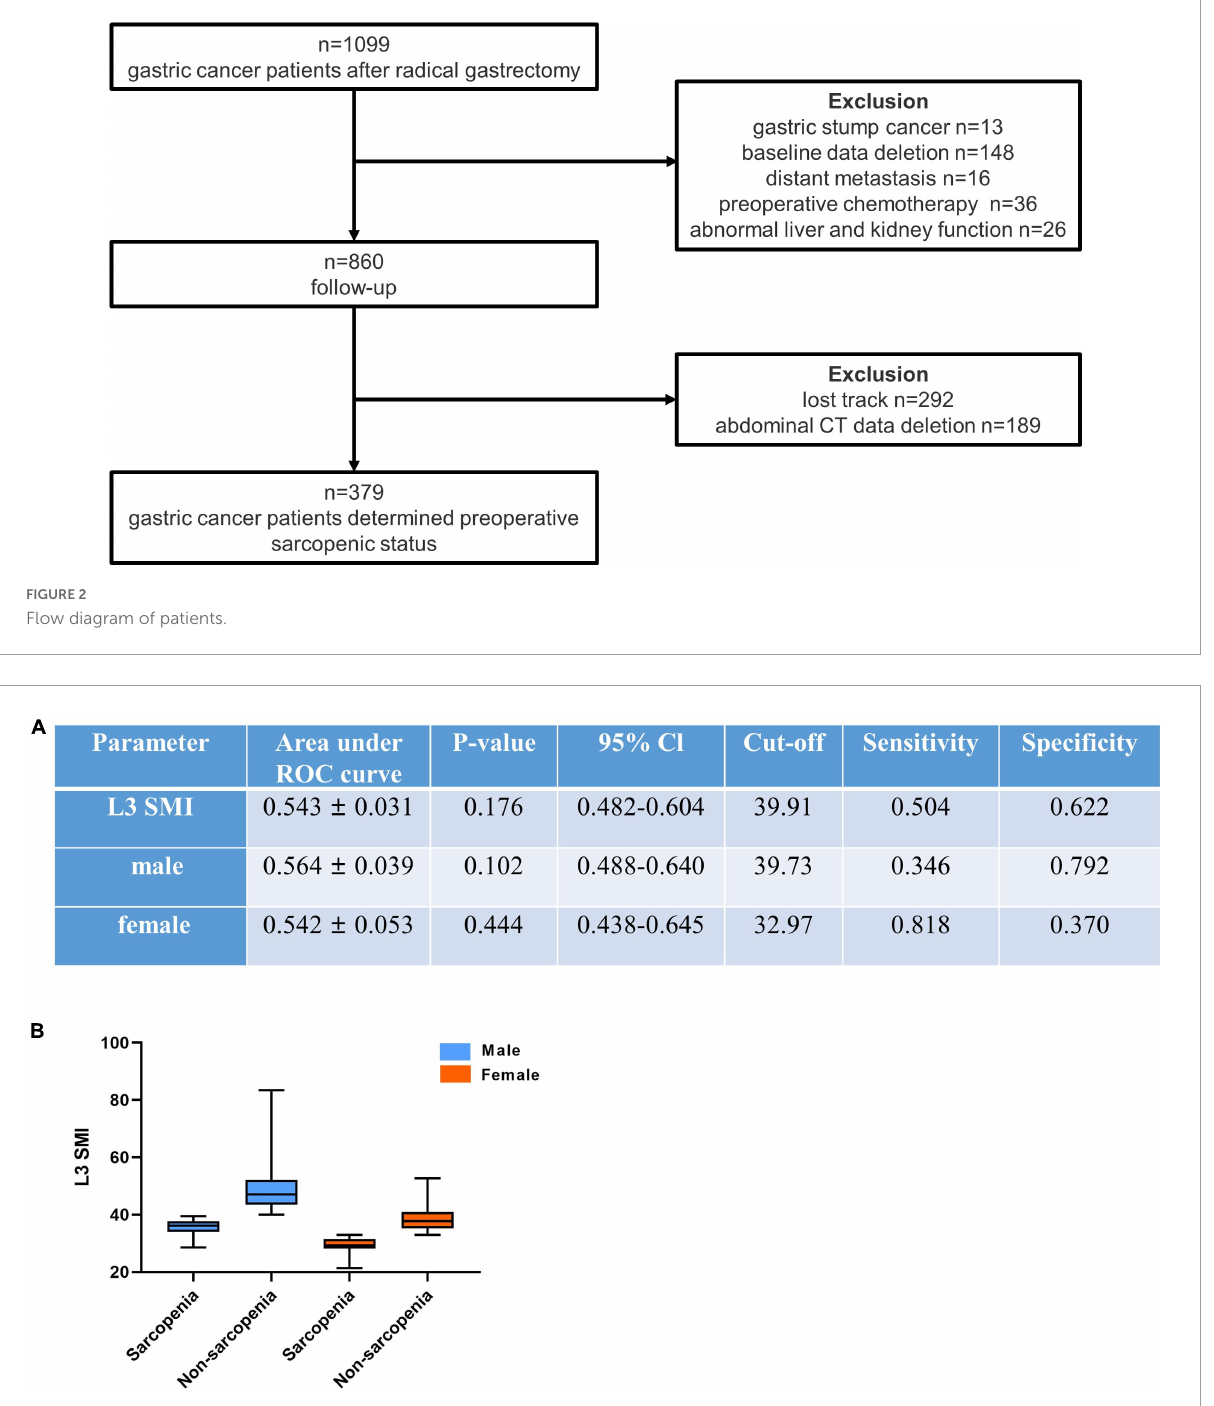
FIGURE3 CT-determined sarcopenic status (A) according to sex-specific L3 skeletal muscle index (L3 SMI) cutoffs for sarcopenia (B) . L3 SMI, L3 skeletal muscle index. The cutoff of SMI was reduced by 100 times for convenience.